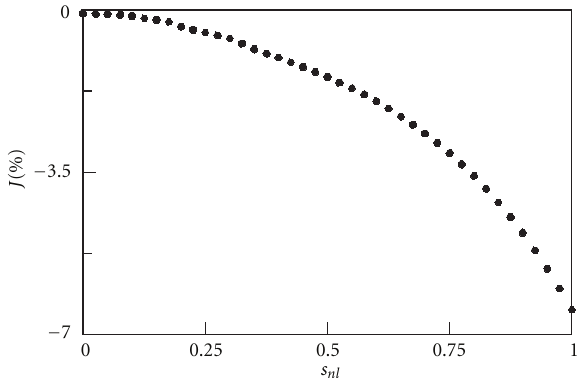
Figure 18: Change in the intensity of single-soliton wing with the change in a value of lumped part of saturable absorber s nl : (1) s nl = 1, (2) s nl = 0 . 75, (3) s nl = 0. The total value of nonlinear losses including lumped and distributed parts remains the